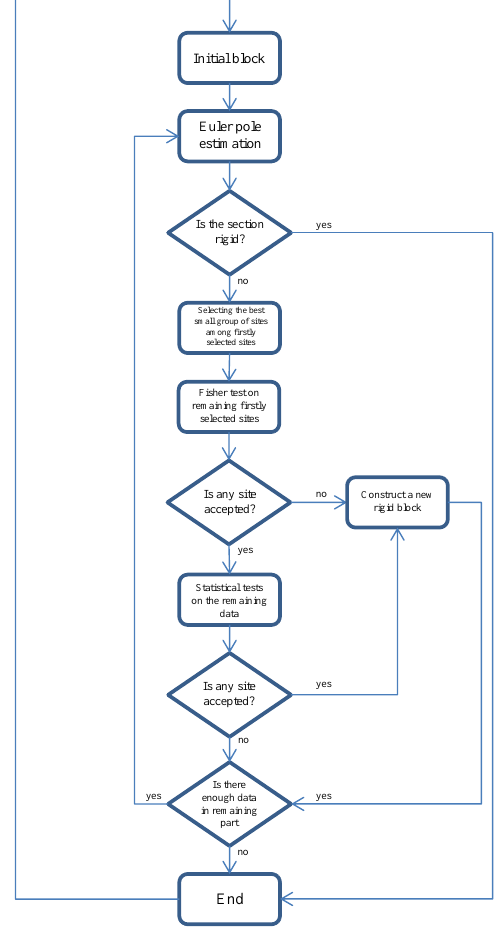
Figure 1. The flowchart of the statistical process for detection of new rigid blocks using an initial pattern of the existing blocks.